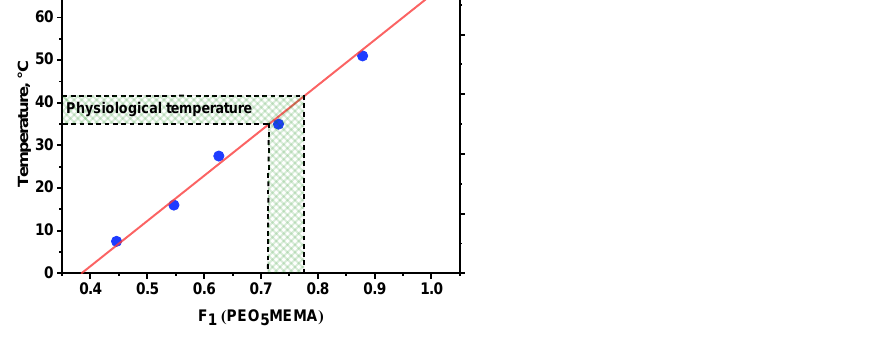
Figure 7. Lower critical solution temperature as a function of p (St- co -PEO 5 MEMA) copolymers com- position.